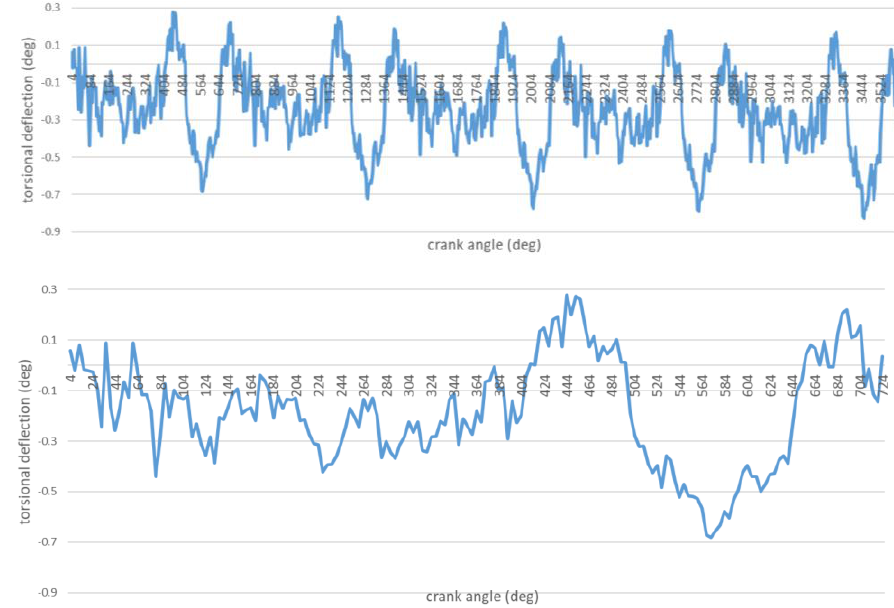
Figure 6. Torsional vibrations of the shaft as a function of the shaft rotation angle. DEU with a defect-free/healthy ship engine (ten turns and one cycle).